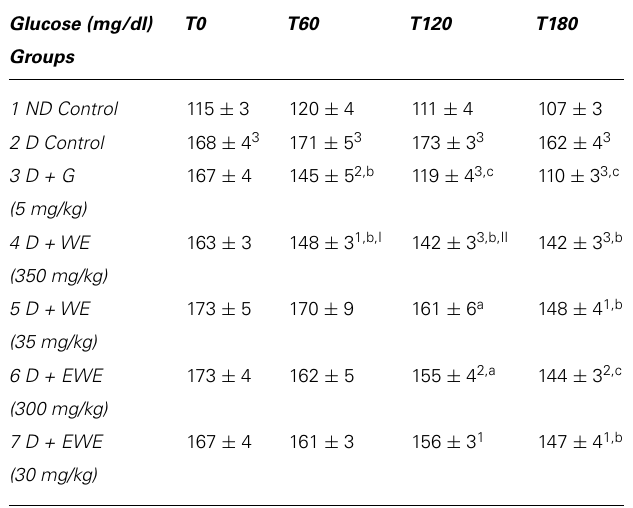
The values represent the means ± SEM. Superscript letters in the same row indicate statistical differences as compared with time 0. Superscript numbers in the same column indicate statistical differences from the control group (diabetic control group compared with non-diabetic control group). Superscript Roman numerals in the same column indicate statistical differences between the two doses of the same extract. “ a,1,I ” indicates significance at p < 0.05, “ b,2,II ” indicates significance at p < 0.01, and “ c,3 ” indicates significance at p < 0.001. Gl, glucose; ND, non-diabetic; D, diabetic; G, glibenclamide; EWE,